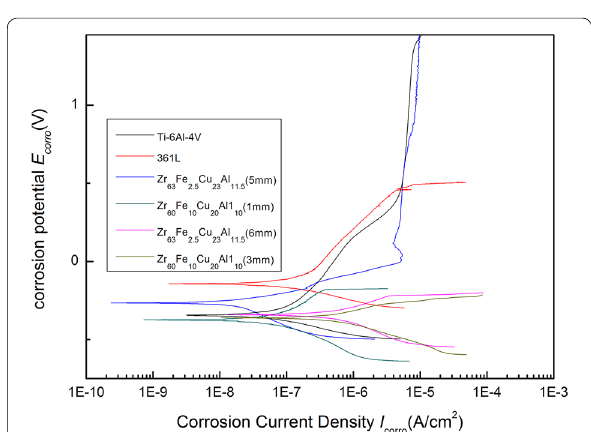
Figure 2 Potentiodynamic polarization curves of as-cast specimens of Zr